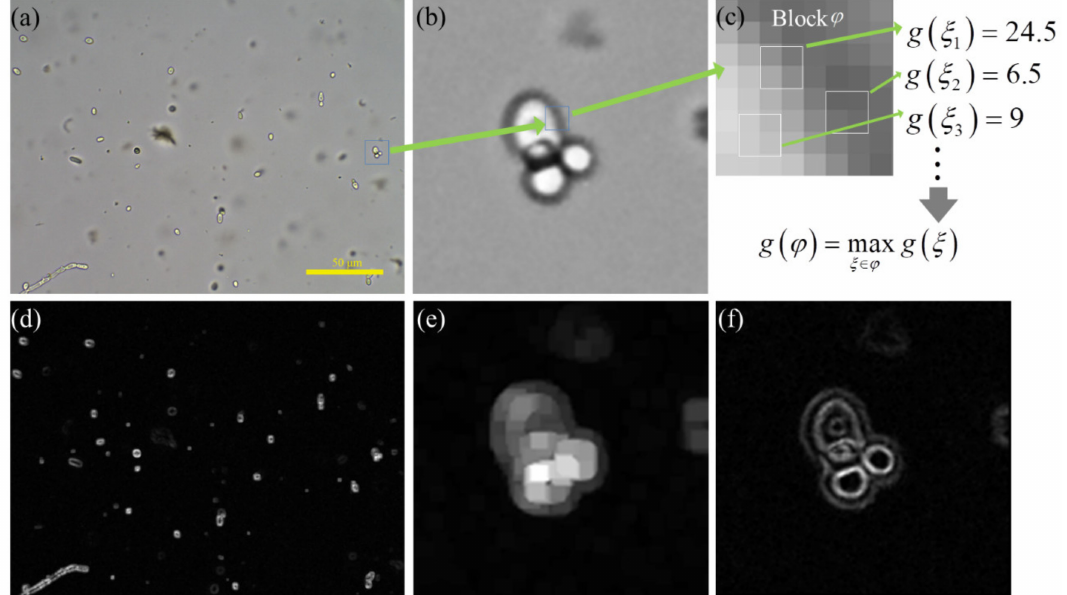
Figure 2. The calculation process of local maximum gradient method. ( a ) is a fecal microscopic image with fungal spores. ( b ) is a local enlargement image of a fungal spore in ( a ). ( c ) is a 8 × 8 image patch, which is defined as block ϕ . ( d , e ) is the feature image of ( a , b ) calculated by local maximum gradient method with s h and s v equal to 1. ( f ) is the feature map of ( b ) calculated by Tenengrad method. ( d – f ) are visual images after normalizing image pixel value to